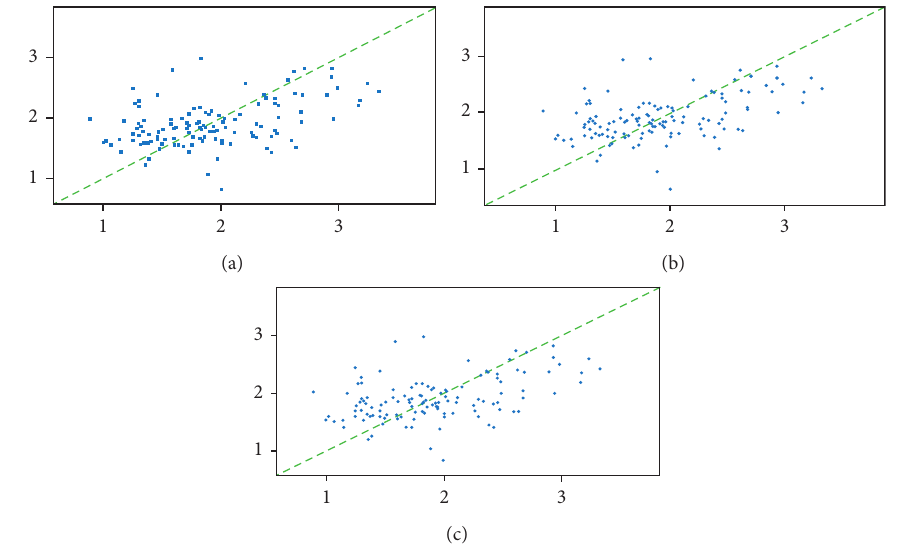
Figure 8: The results obtained from regression to the chemical element K. (a), (b), (c) The results of stepwise regression, PLS regression, and SVR analysis,